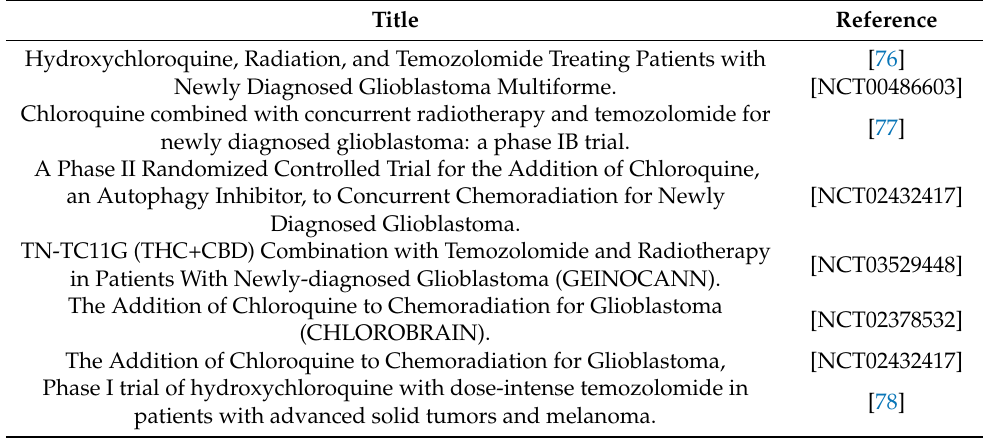
Table 1. Clinical trials that investigate the relation between temozolomide and